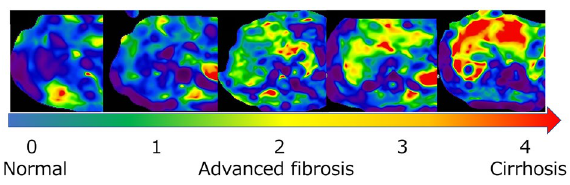
Figure 1. MRE colorized images. MRE magnetic resonance elastography.